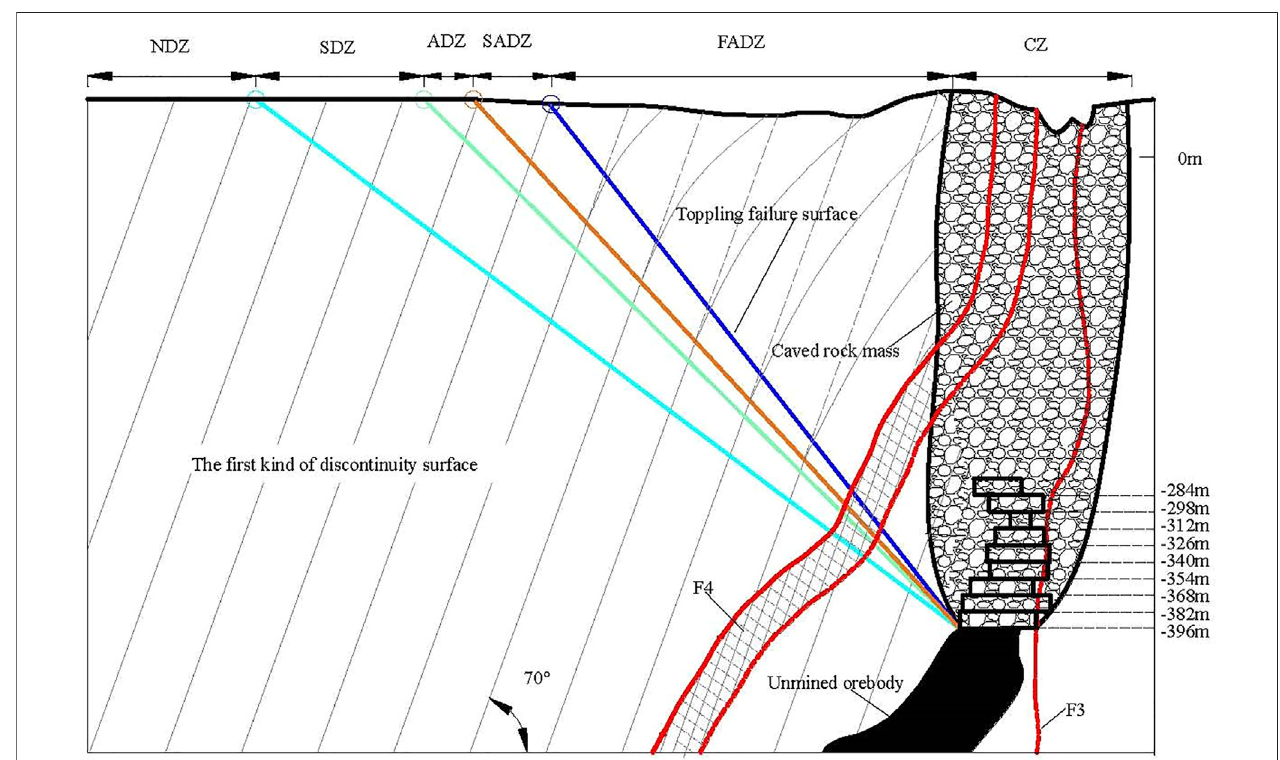
FIGURE 10 | Schematic diagram showing the deformation mechanism in the deep rock strata.